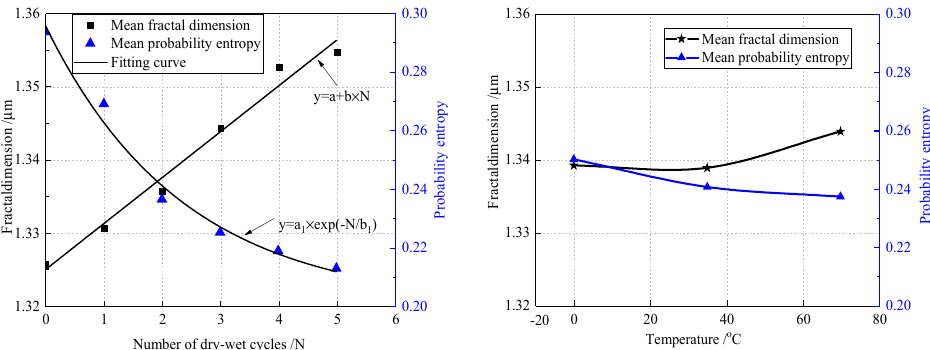
Figure 10. Variation in the microscopic parameters under dry–wet cycling and